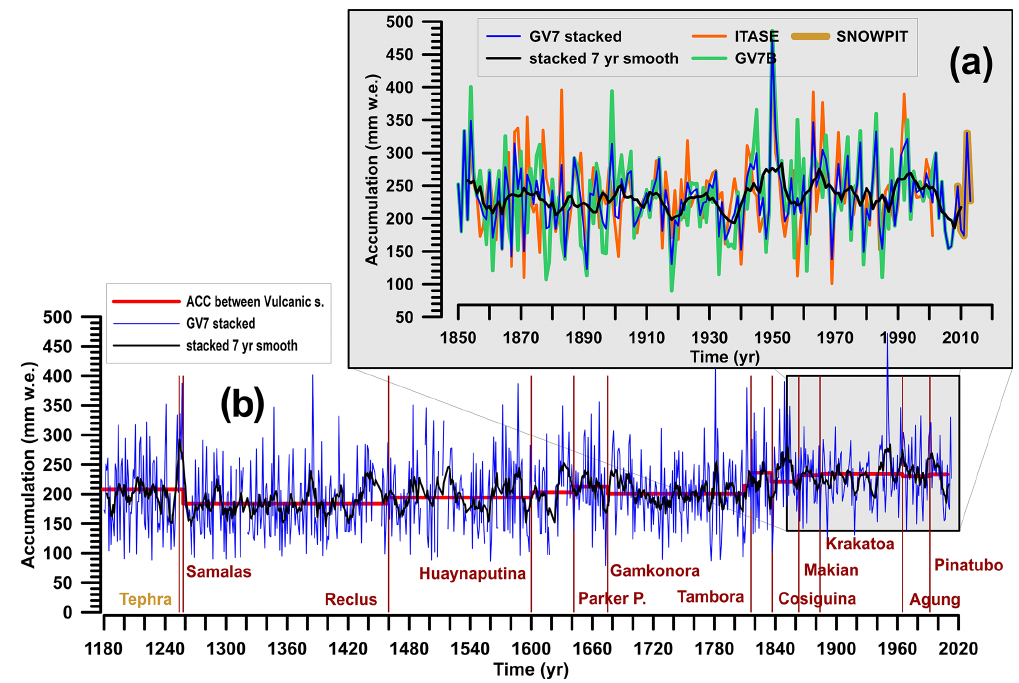
Figure 6. (a) Time series from 1840 to 2020CE of the GV7 snow pit (2008–2013CE, gold line), the ITASE core (1849–2001CE, orange line) and the GV7(B) core (1179–2009CE, green line). Blue and black lines highlight the stacked record, obtained by integrating the snow pit, ITASE and GV7(B) core records, and its smoothing at 7 years, respectively. (b) GV7 stacked time record (1179–2013CE) with a 7-year smoothing average (black line). Vertical red bars highlight volcanic eruption horizons, and the red line shows the average accumulation rate between different volcanic